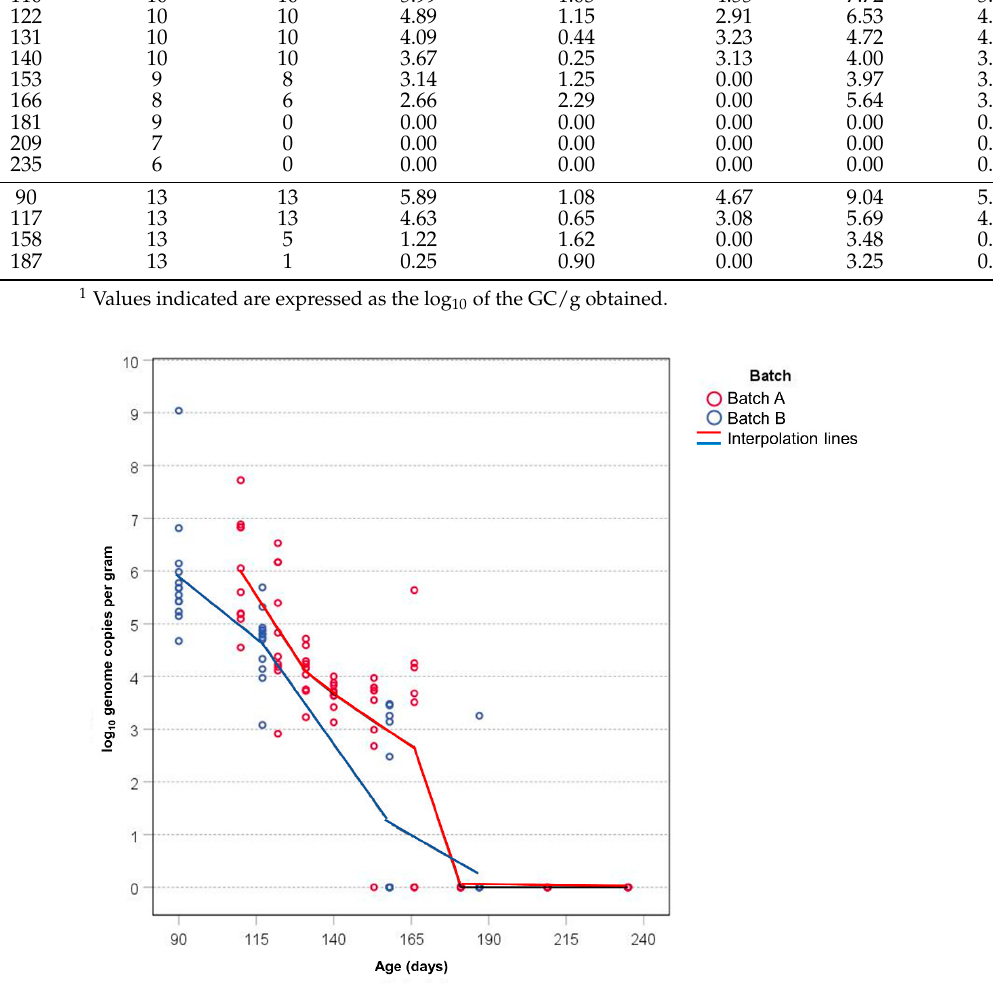
Table 3. Summary of HEV-RNA genome copies per gram (GC/g) of feces, detected by quantitative Real-time RT-PCR at each sampling. Animals GC/g 1 Sampling Batch (T)